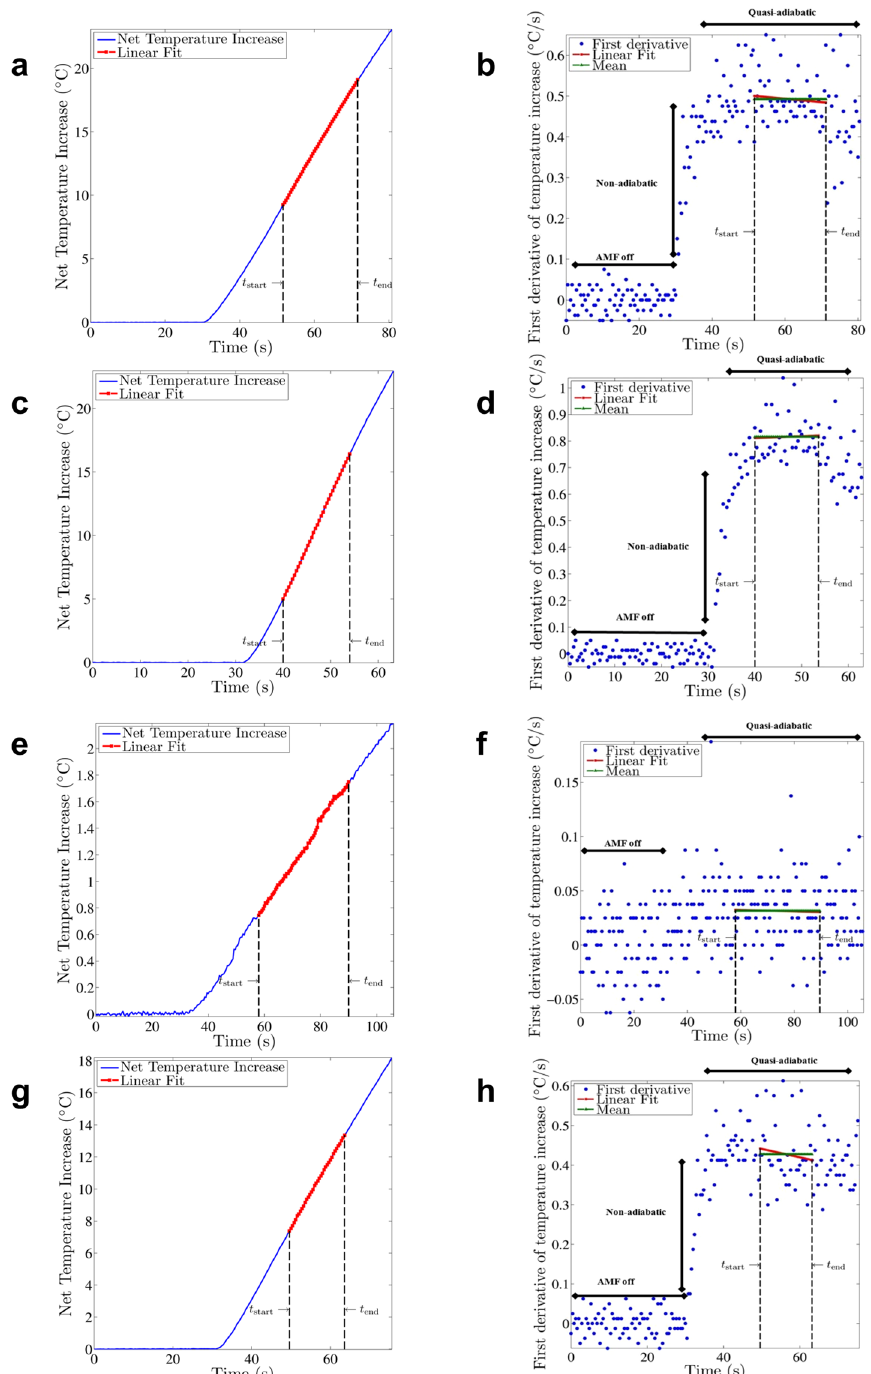
Figure 1. Sample of measured temperature rise data obtained from BNF-Dextran nanoparticles with applied AMF having amplitude 20 kA/m and at frequency 150 kHz. Estimation of SLP from heating rate data requires that (quasi-)adiabatic criteria are met, manifest by linear region of time-temperature curve. A least squares fit of the net temperature increase (sample temperature rise – water blank temperature rise) is performed in a chosen time range (t start , t end ) ( a ). Simultaneously, the mean value and the y-intercept of a least square fit to the incremental net temperature change per time step are determined in the same time range ( b ). In case these values are within 5% of the net temperature rise slope, the heating in the chosen time range is considered to be (quasi)-adiabatic and this net temperature rise slope is used to calculate the SLP 12 . This procedure is repeated for every possible time range and every time range satisfying the criterion from which SLP values are calculated. In this study, the average of all obtained values that meet this criterion is reported as the measured SLP. Analogous figures are presented for JHU nanoparticles ( c , d ), nanomag ® -D-spio nanoparticles ( e , f ), and MnFe 2 O 4 nanoparticles ( g